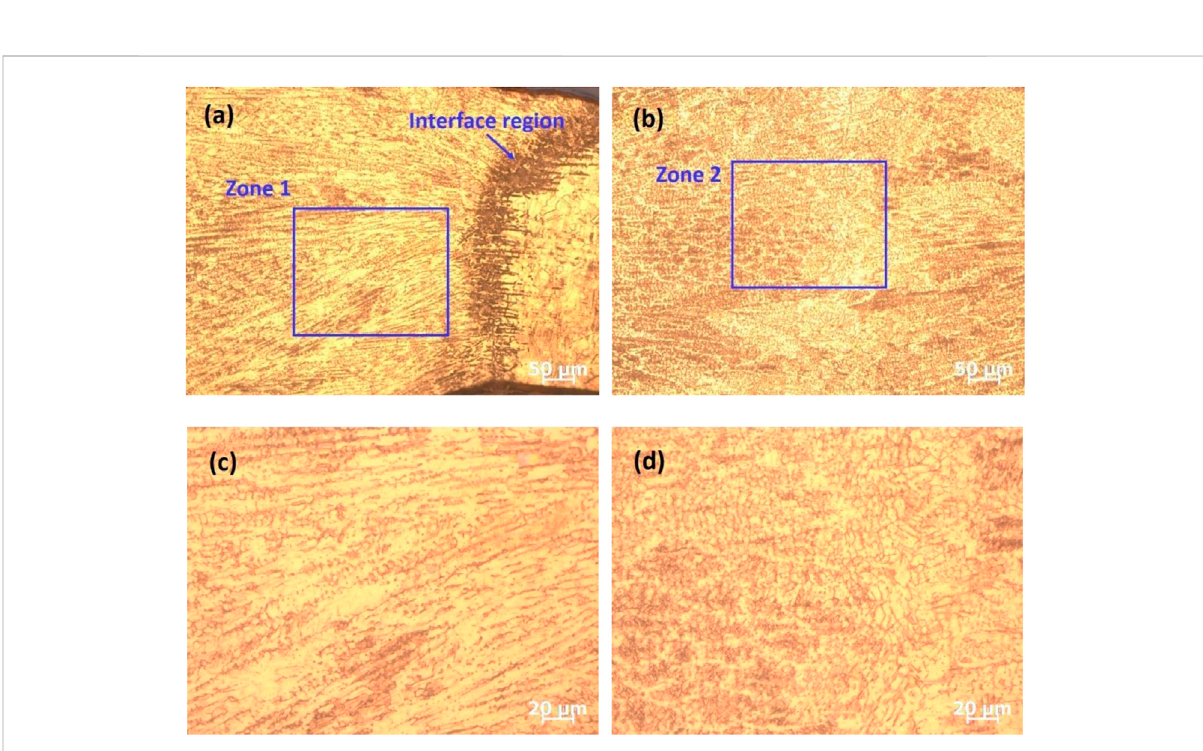
FIGURE 6 Characteristics of the weld zone: (A) microstructure near the interface region, (B) microstructure near the center of the weld zone, (C) magni fi cation of zone 1, and (D) magni fi cation of zone 2.